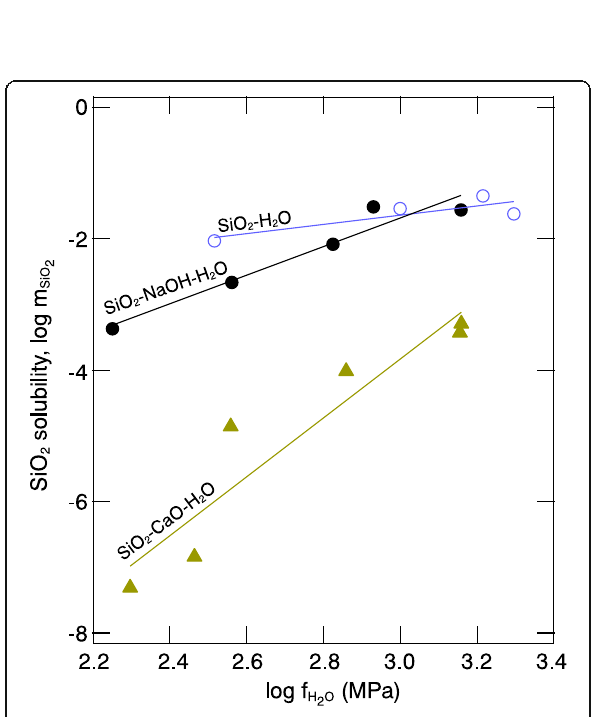
Fig. 6 Silicate solubility in the SiO 2 – H 2 O, SiO 2 – NaOH – H 2 O, and SiO 2 – CaO – H 2 O systems as a function of fugacity of pure H 2 O (see text for details of calculations and source of f H2O